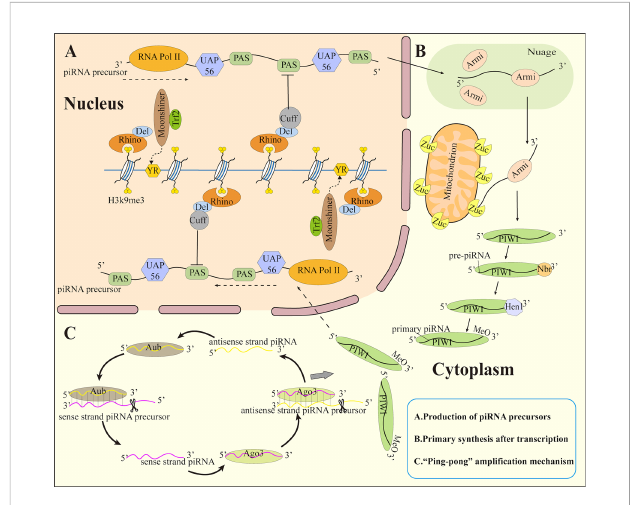
FIGURE 1 Biosynthesis of piRNA. (A) Production of piRNA precursors (B) Primary synthesis after transcription (C) ” Ping-pong ” ampli fi cation mechanism. Trf2, TATA box-binding protein-related factor 2; Del, Deadlock; Cuff, Cutoff; YR, pyrimidin purine; PAS, polyadenylation signal sequence; Armi, Armitage; Zuc, Zucchini; Hen 1, methyltransferase Hen1; Nbr, Nibbler; MeO,